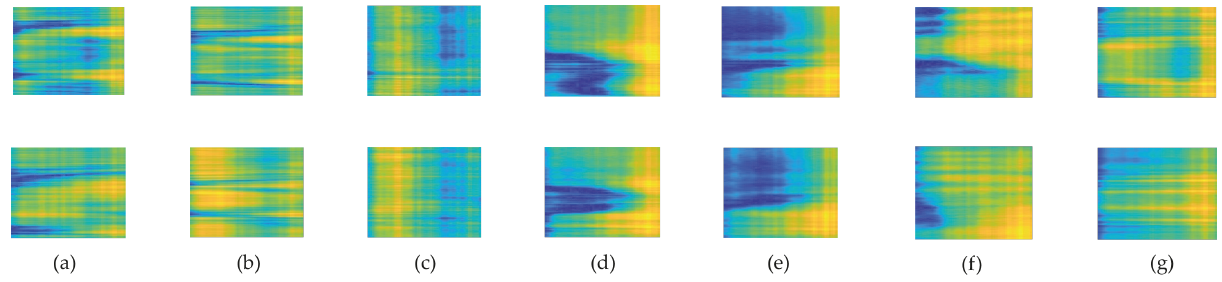
Figure 6. Generated RGB images: ( a ) walk; ( b ) run; ( c ) fall; ( d ) lie down; ( e ) sit down; ( f ) stand up; ( g )